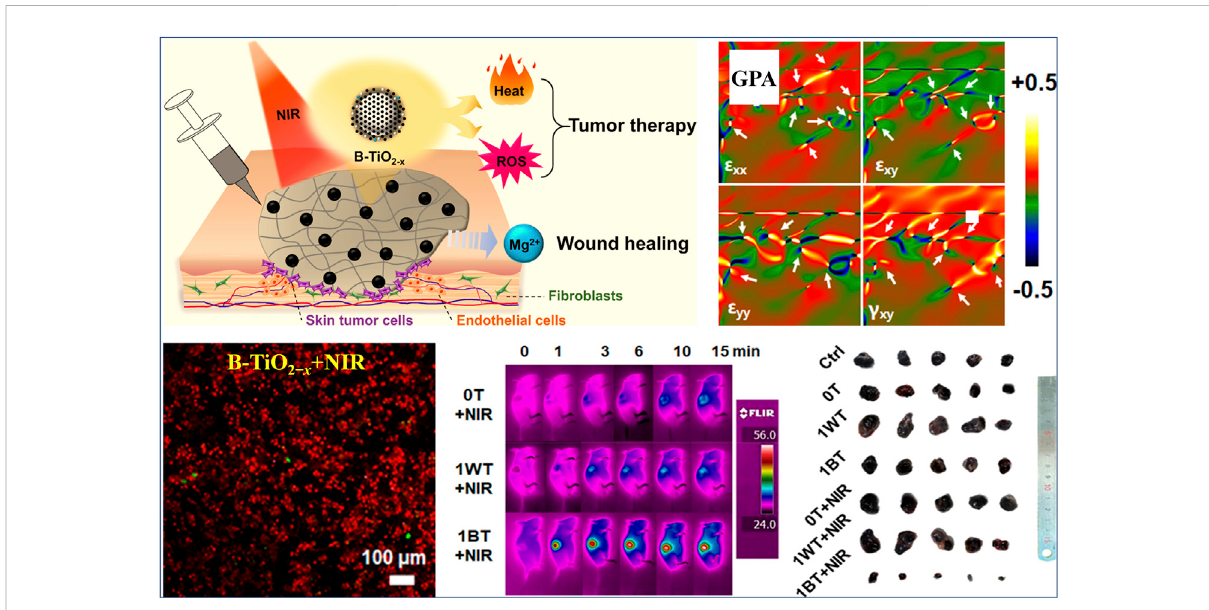
FIGURE 4 Illustration on action mechanism of B-TiO 2 − x for synergetic PTT and PDT, geometric-phase analysis (GPA) of B-TiO 2 − x (white arrows indicate the position of atomic dislocations), calcein AM and PI co-staining of B16F10 melanoma cells after the treatment with B-TiO 2 − x and NIR irradiation, infrared thermal images of B16F10 tumor-bearing mice after various treatments, and representative photographs of the dissected tumors. Reproduced with permission from Wang X. et al. (2019). Copyright © 2019 American Chemical